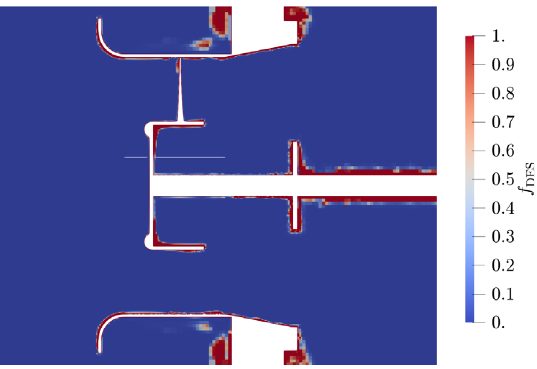
Figure 7. y + criterion on the fan and duct.